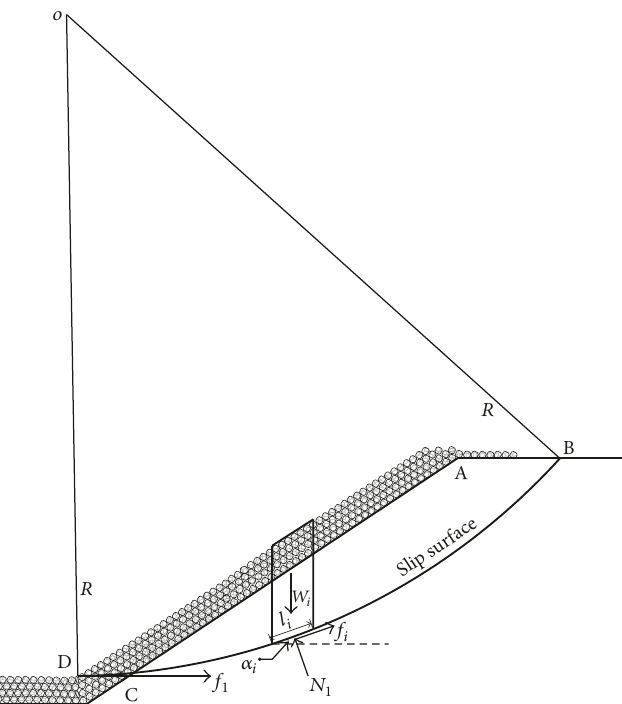
Figure 8: Forces acting on the soil nets structure and the underlying